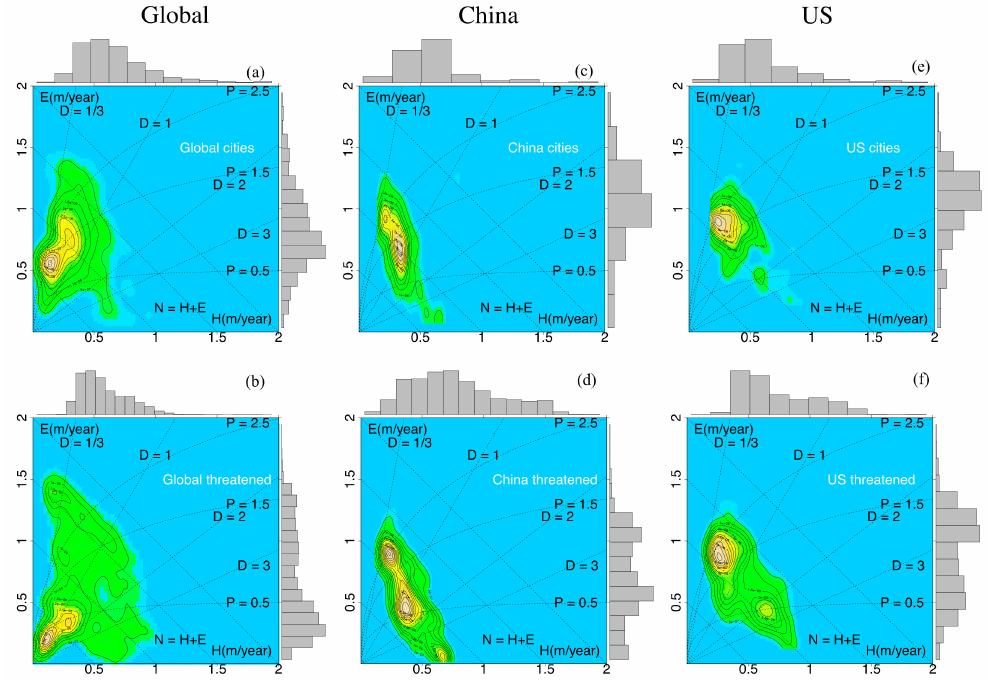
Figure 2. Frequency distribution of the climatological means of surface evapotranspiration E and sensible heat flux H presented in ( E , H )-state space for ( a , b ) Globe, ( c , d ) China and ( e , f ) America cities (upper row) and threatened species (bottom